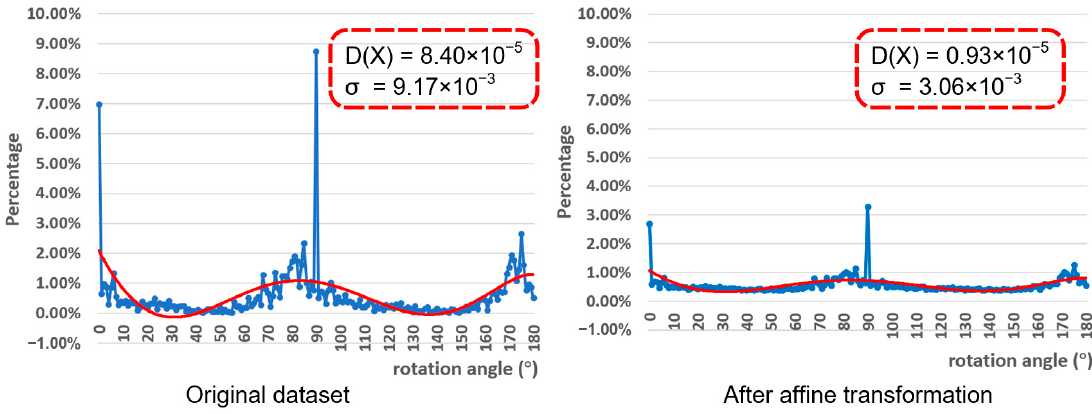
Figure 10. Distribution of tilt angles (ITCVD dataset).